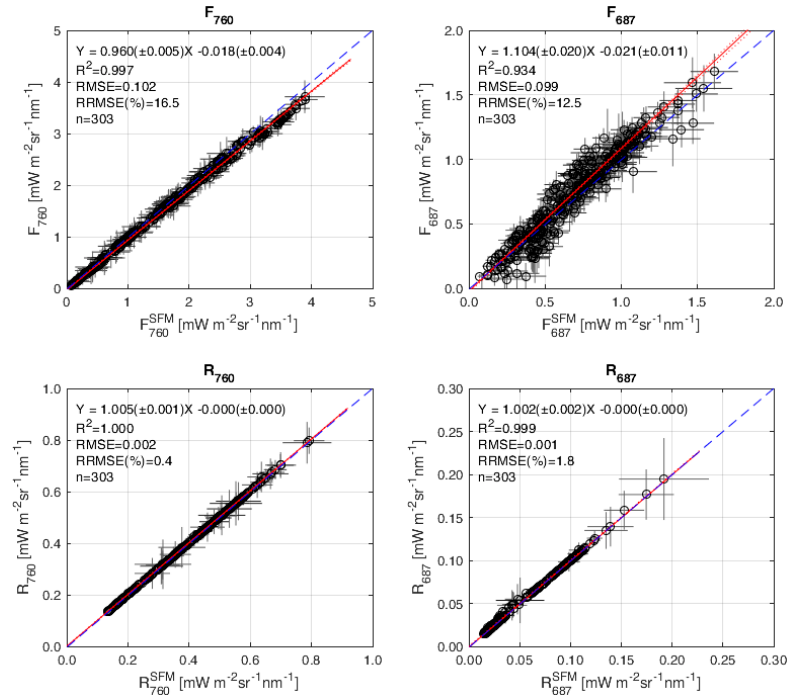
Figure 11. Scatterplot between fluorescence ( top ) and reflectance ( bottom ) at 760 nm ( left ) and 687 nm ( right ) estimated by SFM and the novel F spectrum algorithm. The dots represent hourly average values (standard deviation) for the entire time series acquired on different crops during the entire season. The red line is the OLS linear regression model; dashed blue line the 1:1. For the first time, the temporal evolution of the full F spectrum and R along the entire growing season for one of the crops investigated is depicted in Figure 12. The time series collected over forage canopy was selected because it ranges from almost bare soil (DOY = 52) to full canopy development (DOY = 145). The data reported refer to 28 selected days characterized by clear-sky conditions and the spectra are average values within one hour around solar noon. The analysis of data collected at noon limits canopy directional effects that typically affect diurnal cycle measurements [53], providing an easier inter-day comparison along the growing season. The F and R spectra observed are on the left side, while temporal evolution of F values at specific wavelengths and selected ancillary indices are on the right side. Specifically, F RED , F FAR-RED , F INT values are selected to show the temporal evolution